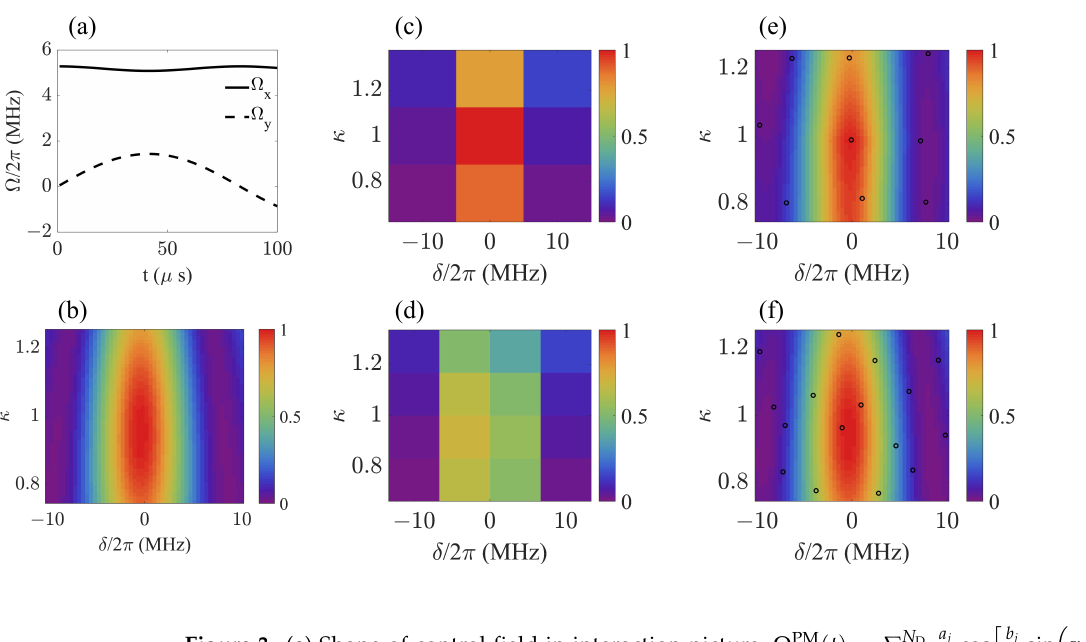
Figure 3. ( a ) Shape of control field in interaction picture, Ω PM x ( t ) = ∑ N D (cid:104) b (cid:16) (cid:17)(cid:105) a j Ω PM j ( t ) = ∑ N D v j t sin sin , with randomly taken parameters a = 0.0332, b = 0.0104 and y v j 2 j = 1 ν = 0.0378. ( b , c ) Values of true function with sample number N s = 9. ( d ) Values of true function with sample number N s = 16. ( e ) Values of estimation function with sample number n = 9 and estimation point number N e = 2500. ( f ) Values of estimation function with sample number n = 16 and estimation point number N e = 2500. Black circles in ( e , f ) represent locations of sample